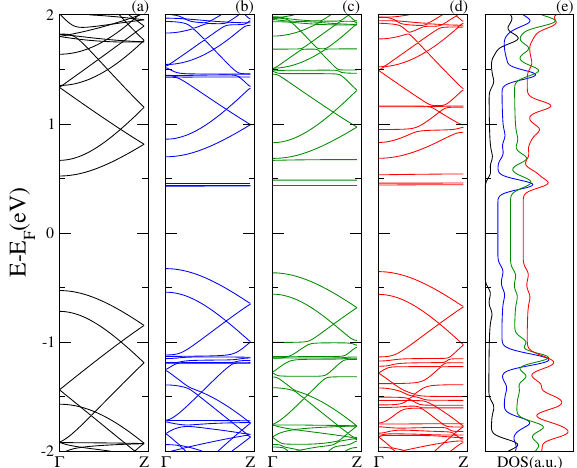
Figure 5. Electronic band structure of the 10GR–fullerene system for a wave vector along the z direction. Each panel displays the energy bands for the pristine 10GR in ( a ), and for the different hybrid systems: 10GR–C 60 in ( b ), 10GR–PCMB in ( c ), and 10GR–C 70 in ( d ). Panel ( e ) shows the total